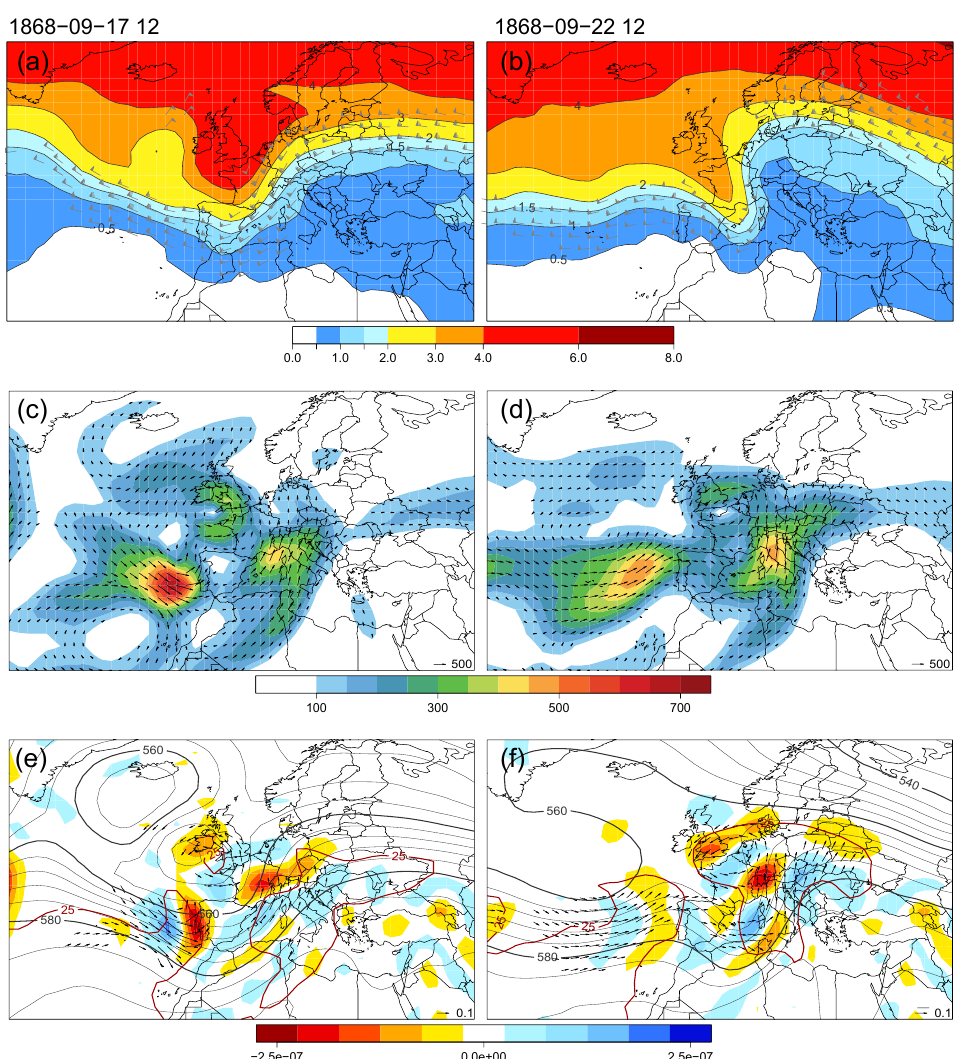
Figure 6. Synoptic analyses for 17 September 1868 12:00UTC (a, c, e) and 22 September 1868 12:00UTC (b, d, f) . (a, b) PV units at the 330 Kelvin isentrope, and wind speed (in ≥ 50 knots according to wind barbs) at 250hPa. (c, d) Integrated water vapor transport (shade and vectors; kgm − 1 s − 1 ) . (e, f) Moisture flux divergence (gkg − 1 s − 1 ; shade; negative values indicate flow convergence) and transport (ms − 1 kgkg − 1 , vectors) at 850hPa levels, geopotential height (bold and dashed black isolines; decameters) at 500hPa, and precipitable water for the entire atmosphere (red contours indicate 25kgm − 2